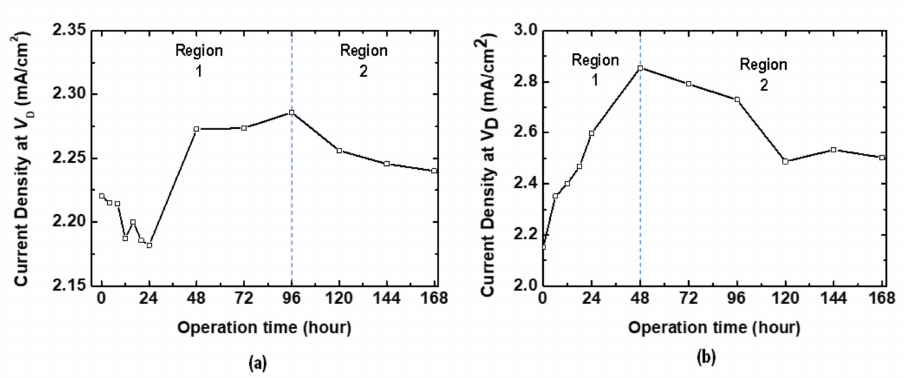
Figure 4. Current densities at V D as a function of operation time for the constant current stresses at ( a ) 2.5 × J D and ( b ) 15 × J D .